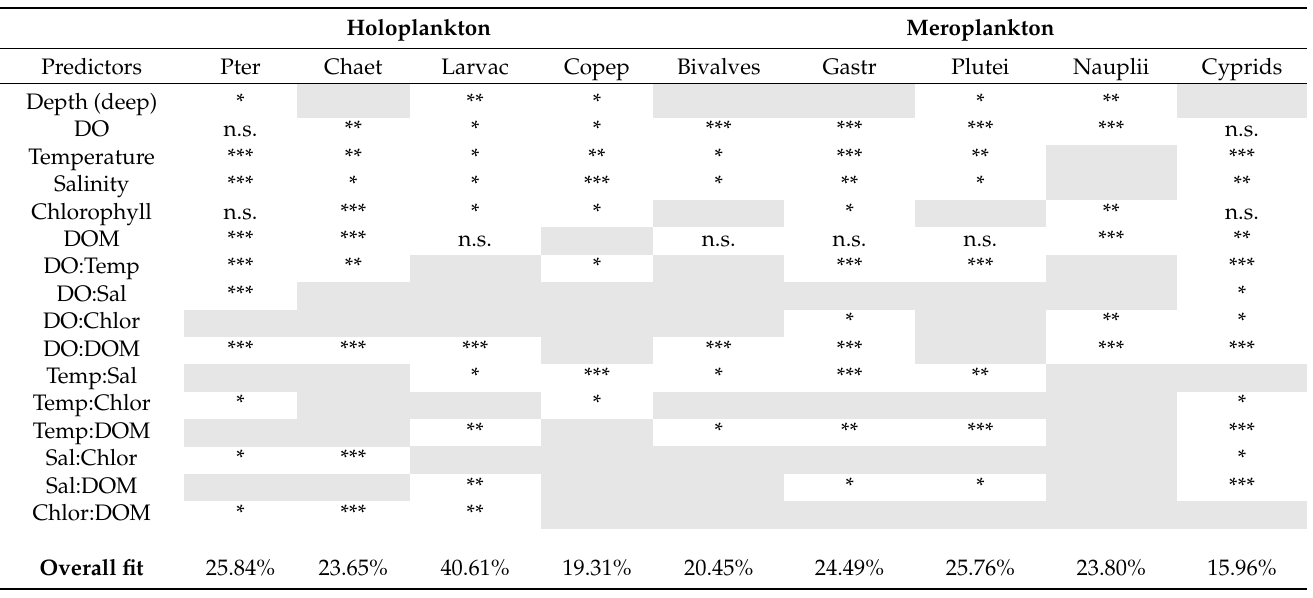
Table 3. Univariate results of GLM analysis on raw abundance data, assuming negative binomial distributions to account for overdispersion, following stepwise removal of non-significant 2nd order interactions and main effects. Asterisks denote p -values: * < 0.05; ** < 0.01; *** < 0.001; n.s. = not significant (main effects only). Grey cells denote variables removed from the model. Pter = pteropods; Chaet = chaetognaths; Larvac = larvaceans; Copep = copepods; Gastr = gastropod veligers; Bivalves = bivalve veligers; Nauplii = barnacle nauplii; Cyprids = barnacle cyprids. Overall fit for each final model calculated as 1—(Residual variance/null